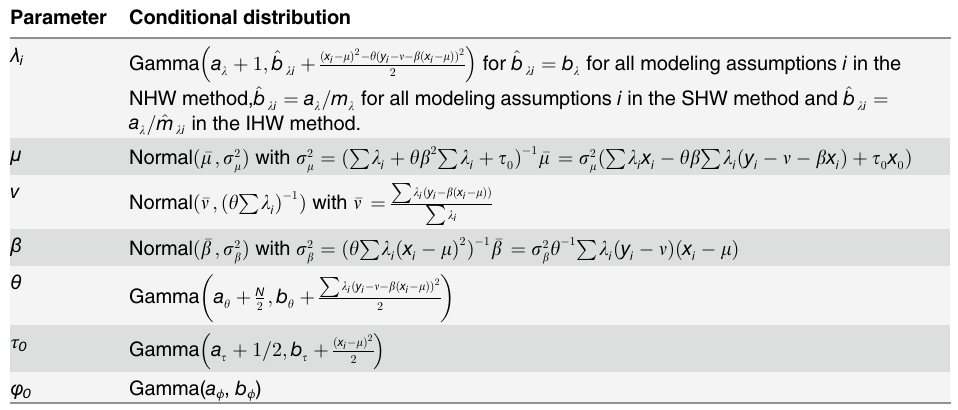
Table 3. Conditional distributions used for updating via Gibbs sampling for the single quantity